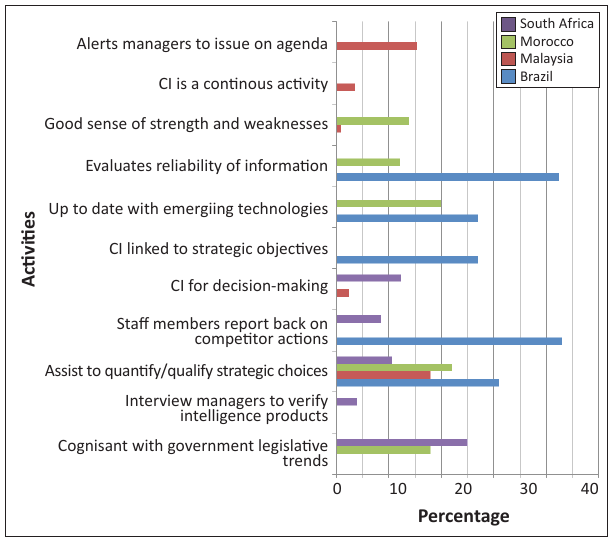
FIGURE 2: The five most important competitive intelligence activities listed by